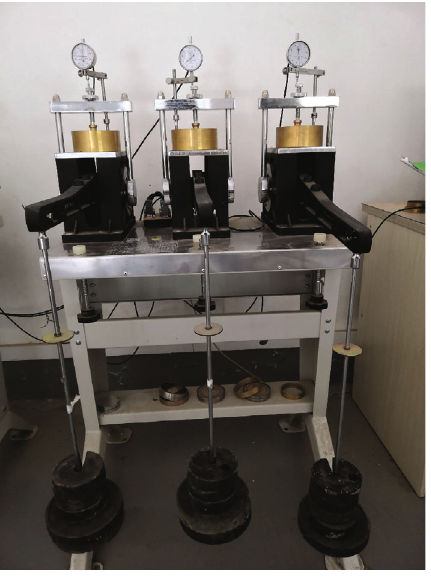
Figure 4: Expansion force testing